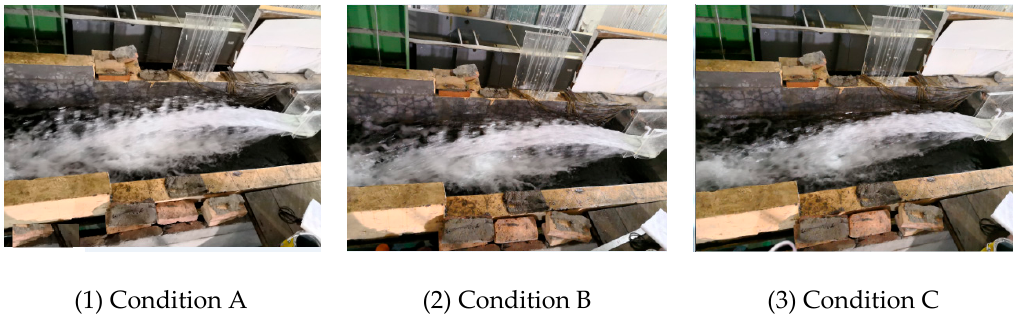
Figure 5. Water nappe flow patterns with a swallow-tailed bucket.